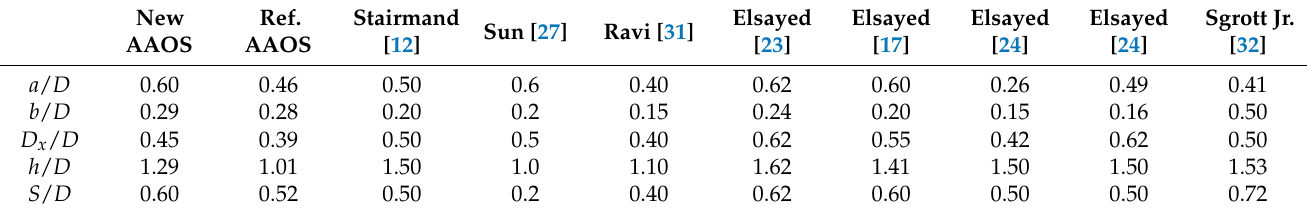
Table 4. Comparison of geometric parameters of the current and previous optimal